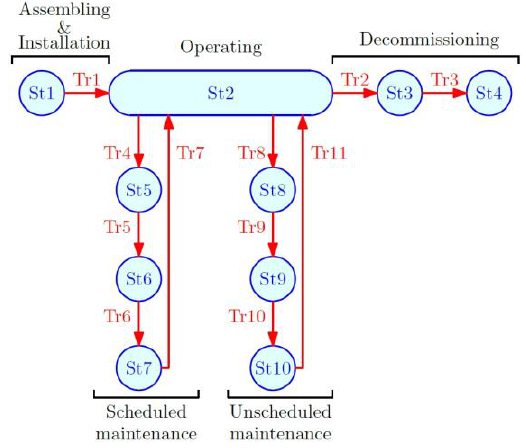
Fig. 2. WEC state block diagram.